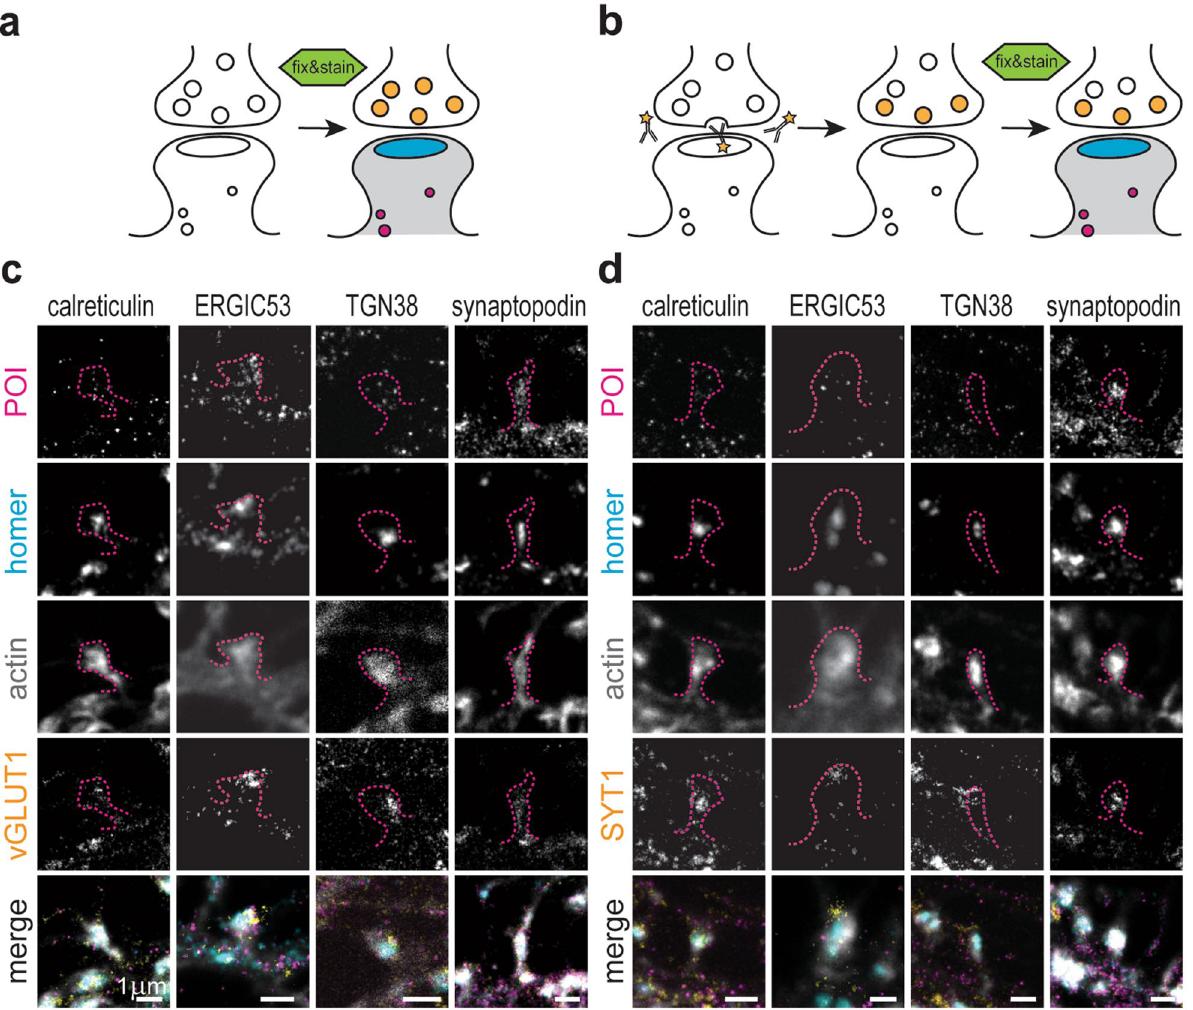
Figure 1. Experimental design and presence of secretory elements at post-synaptic sites. ( a ) Cells were either directly fixed and stained when visualising vGLUT1 or ( b ) incubated with an Atto647N-tagged anti-SYT1 antibody directed towards the extracellular domain of SYT1 prior to fixation. When a vesicle fuses with the pre-synaptic site, the SYT1 epitope becomes accessible to the antibody, which is incorporated by endocytosis within the recycling synaptic vesicle. Thereby, this label provides an estimate of activity at the respective synaptic boutons. ( c , d ) Representative STED images of individual synaptic sites in mature hippocampal neuron cultures. Samples were stained for several proteins of interest (POI: calreticulin, ERGIC53, TGN38, synaptopodin), with pre- and post-synaptic sites markers (vGLUT1 or SYT1, and homer, respectively), and phalloidin (actin, confocal). Secretory elements were found in the proximity of post-synaptic sites. Dashed lines represent the spine outline as labelled by phalloidin. Scale bars: 1 for each bin. The average images represent the protein distribution around the synaptic sites, sorted by their respective homer intensity: a strong signal at the centre indicates a higher relative protein level in proximity of the synaptic site, while a more diffuse signal indicates that the protein is probably present in compartments more distant to the synaptic site, such as the dendritic shaft (Fig. 2a). Interestingly, while only a minor increase in the spread was noticed for calreticulin, ERGIC53 and synaptopodin at increasing homer intensities, TGN38 appeared vastly affected by low and intermediate post-synaptic strengths. To quantify this redistribution, a radial analysis was performed on the average images, and the ratio between the signal in the periphery and at the centre was calculated (Fig. 2b, Supplementary Fig. 5a). Low ratio values indicate a higher concentration of the POI at the synaptic site, while values close to 1 indicate a spread-out distribution. Such analyses revealed that calreticu- lin, ERGIC53, and synaptopodin exhibit a slight linear increase in their distribution in the area surrounding the synaptic site (the radial intensity profile ratio increased by 0.18, 0.15 and 0.13, respectively). On the other hand, TGN38 spread appeared to be modulated already by small increases in the post-synaptic strength (0.3 increase of radial intensity profile ratio between bin 1 and bin 3), but this modulation rapidly reached a plateau. From these results it could be concluded that the strength of the post-synapse has a minor influence on the distribution of the elements of the secretory pathway in the synaptic site.